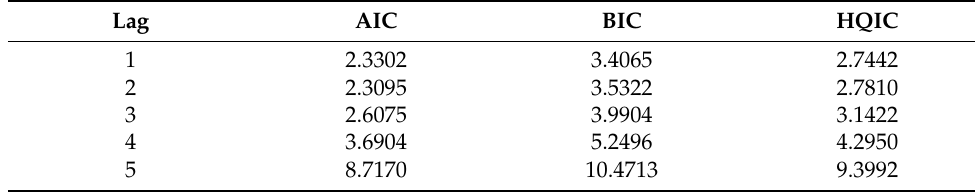
Table 5. Results of the multicriteria